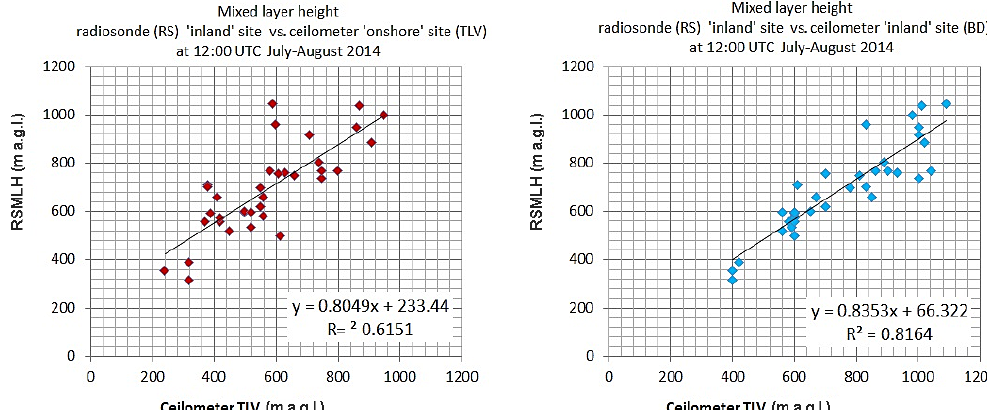
Figure 11. Same as Fig. 10 but for